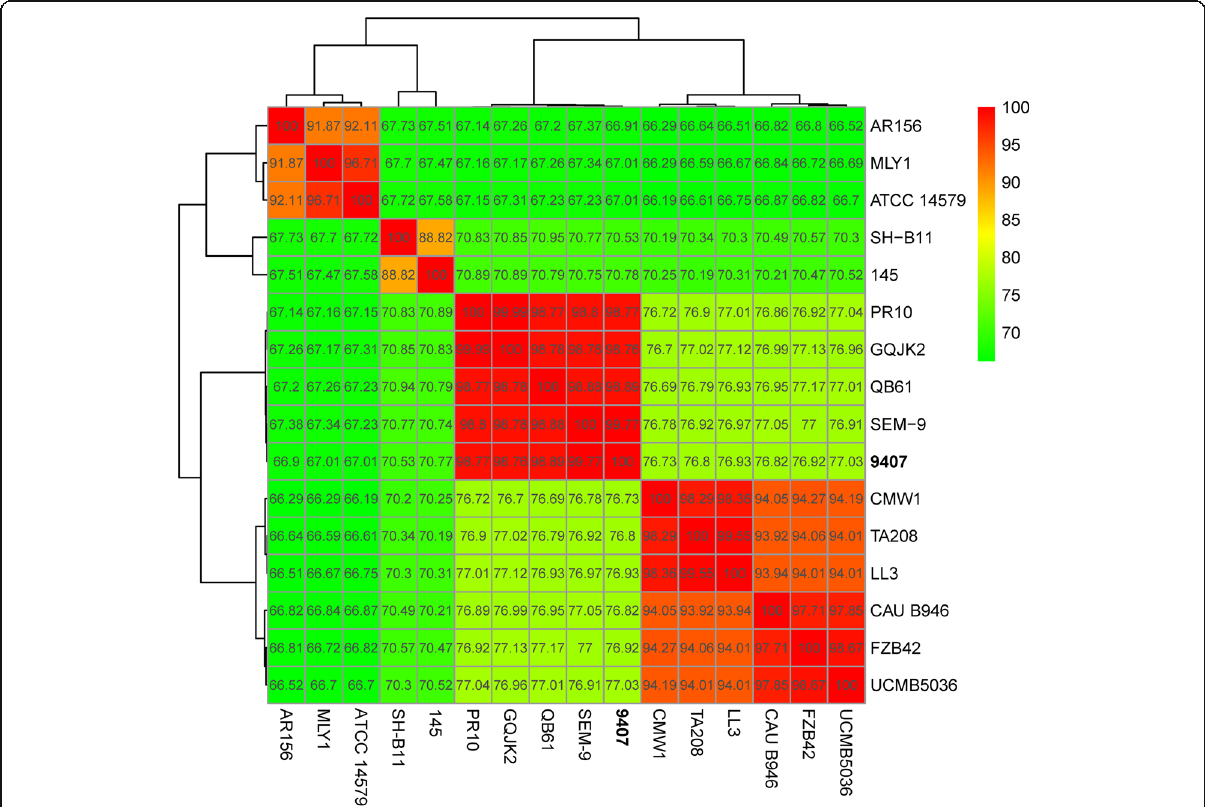
Fig. 2 Heat-map of Average Nucleotide Identity (ANI) values amongst different Bacillus strains. The numbers represent the size of ANI